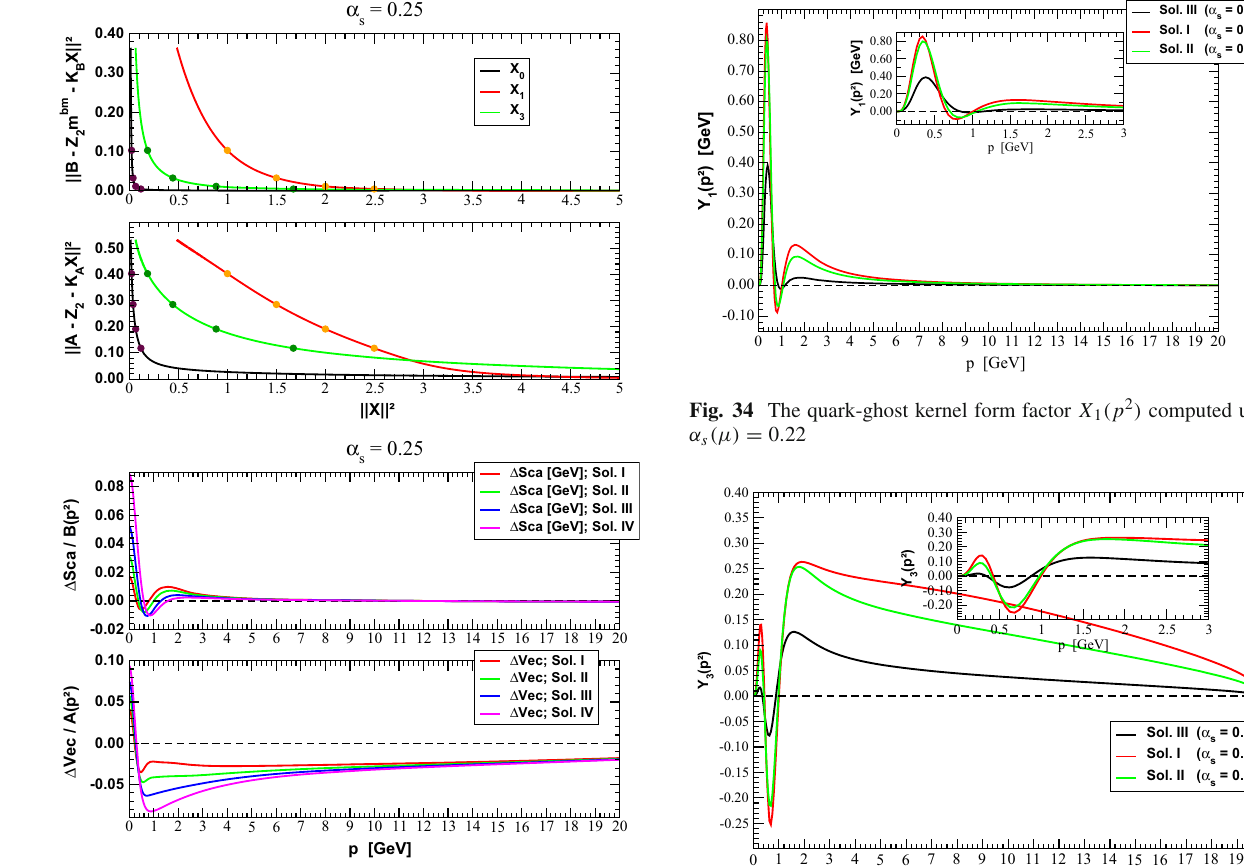
Fig. 32 NormversusResiduum(top)andrelativeerrorofthesolutions of the gap equation for α s (μ) = 0 . 25. The solutions on the right plot are those marked on the left plot with I being that associated to the most right mark